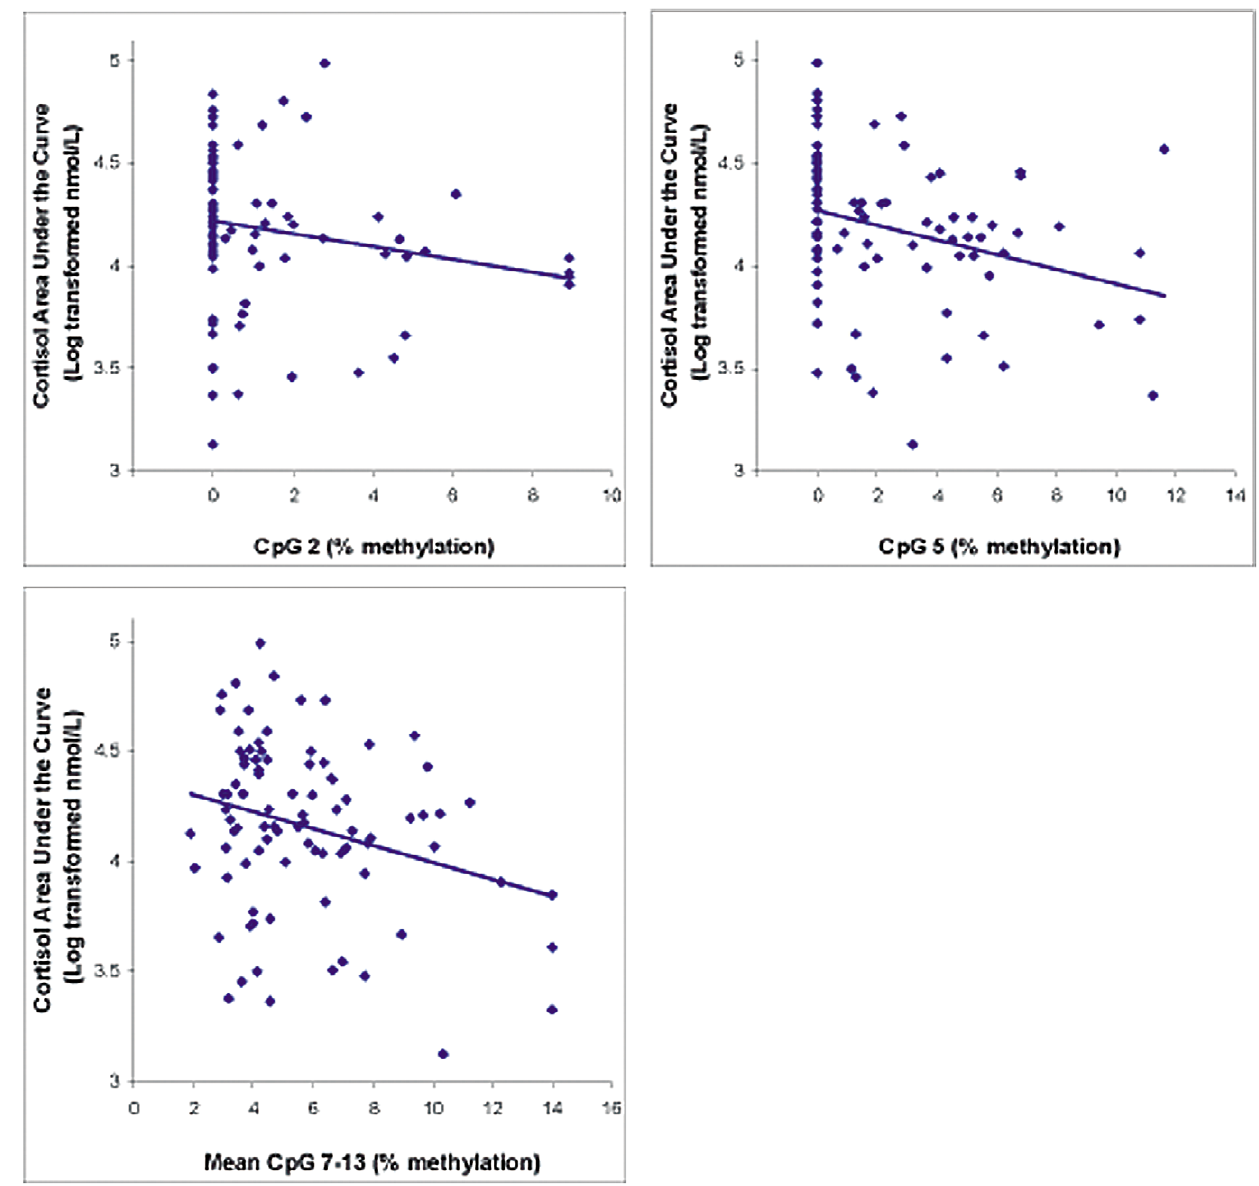
Figure 3. Significant Associations of Cortisol AUC in the Dex/CRH Test and Percent Methylation at CpG Sites. AUC is defined as Area Under the